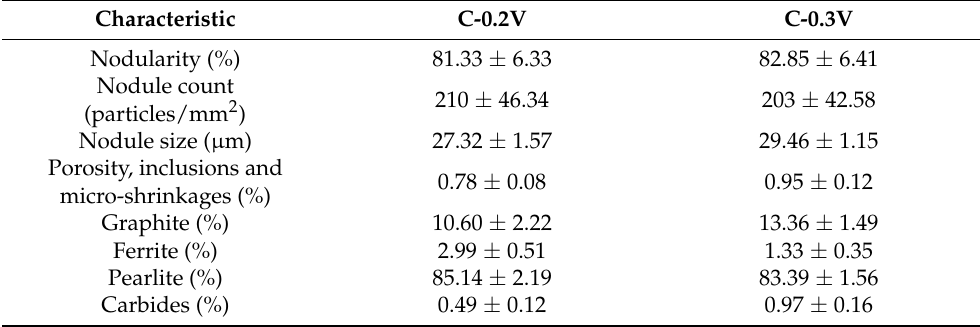
Table 4. Graphite features and volume fraction of phases formed for the camshafts alloyed with